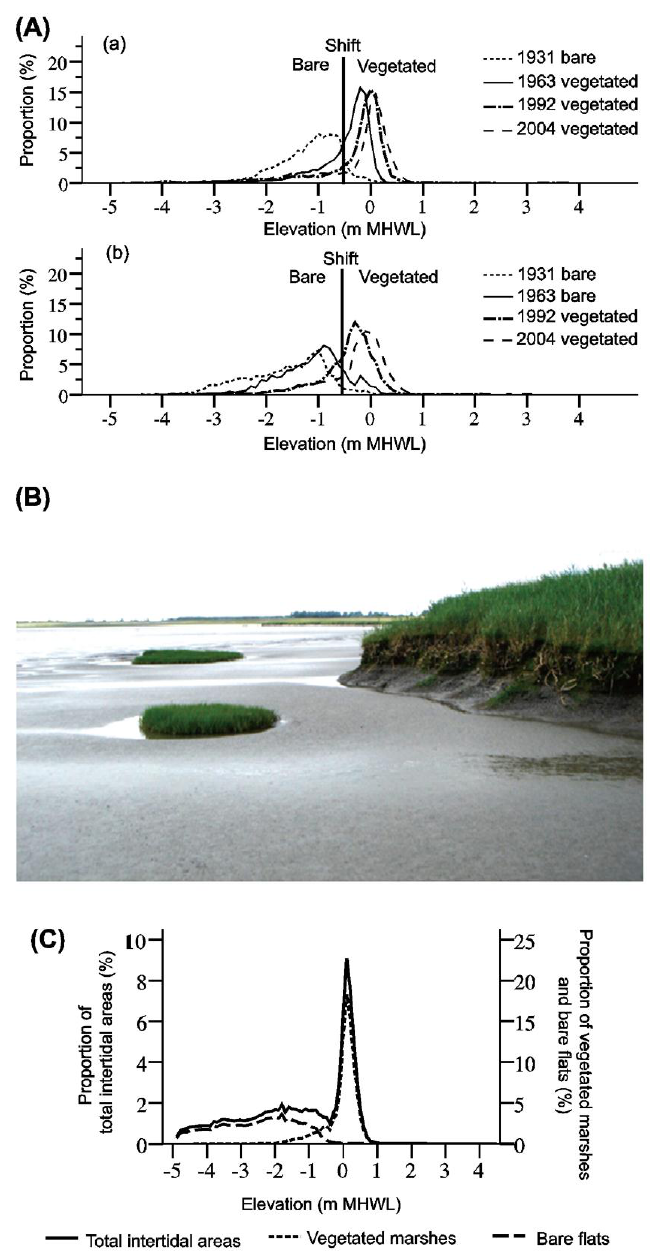
Figure 3. Key attributes of alternative stable states in coastal wetlands. ( A ) Multimodal frequency distributions, abrupt state shifts, and hysteretic response are indicated by pronounced elevation distribution changes in areas that shifted from bare flats to vegetated marshes in 1931–1963 ( a ) and 1963–1992 ( b ) in the Western Scheldt estuary [86], and then were more likely to persist in the new state than return to the prior state; ( B ) Sharp spatial boundaries between contrasting states or habitat units are shown by high-elevation, vegetated marshes and low-elevation, bare tidal flats, with a sharp transition (cliff) between them, Western Scheldt estuary, southwest Netherlands. Pioneer vegetation patches accreting sediment on the tidal flat concurrent with surrounding erosion (scour) may contribute to an incipient state shift; ( C ) Multimodal frequency distribution of intertidal elevations in the Western Scheldt estuary shows each mode related to a specific state (vegetated vs . bare) [86]. On x-axes, m MHWL = meters above mean high water level. (Photo: Alexandra